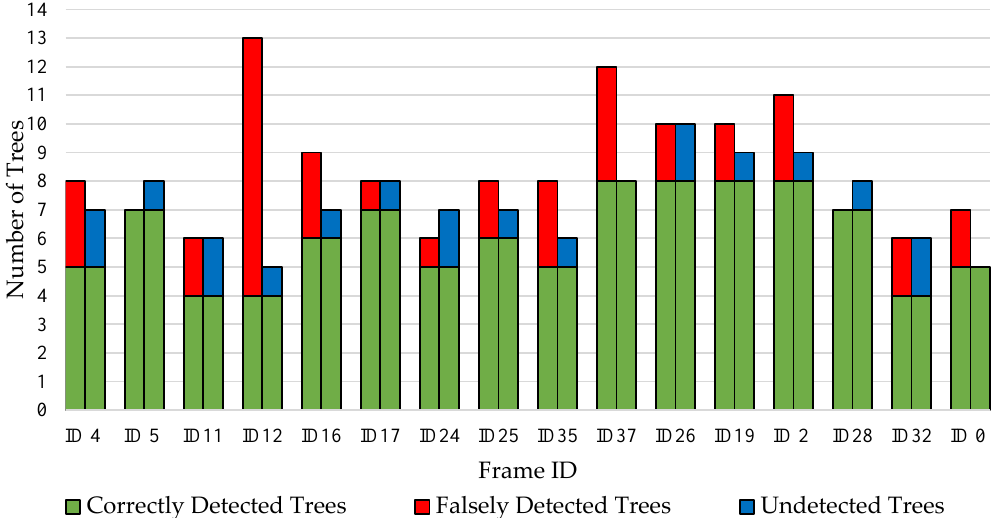
Figure 8. Manual validation compared to algorithm results. Table 4. Results of tree detection of the 40 observed trees.